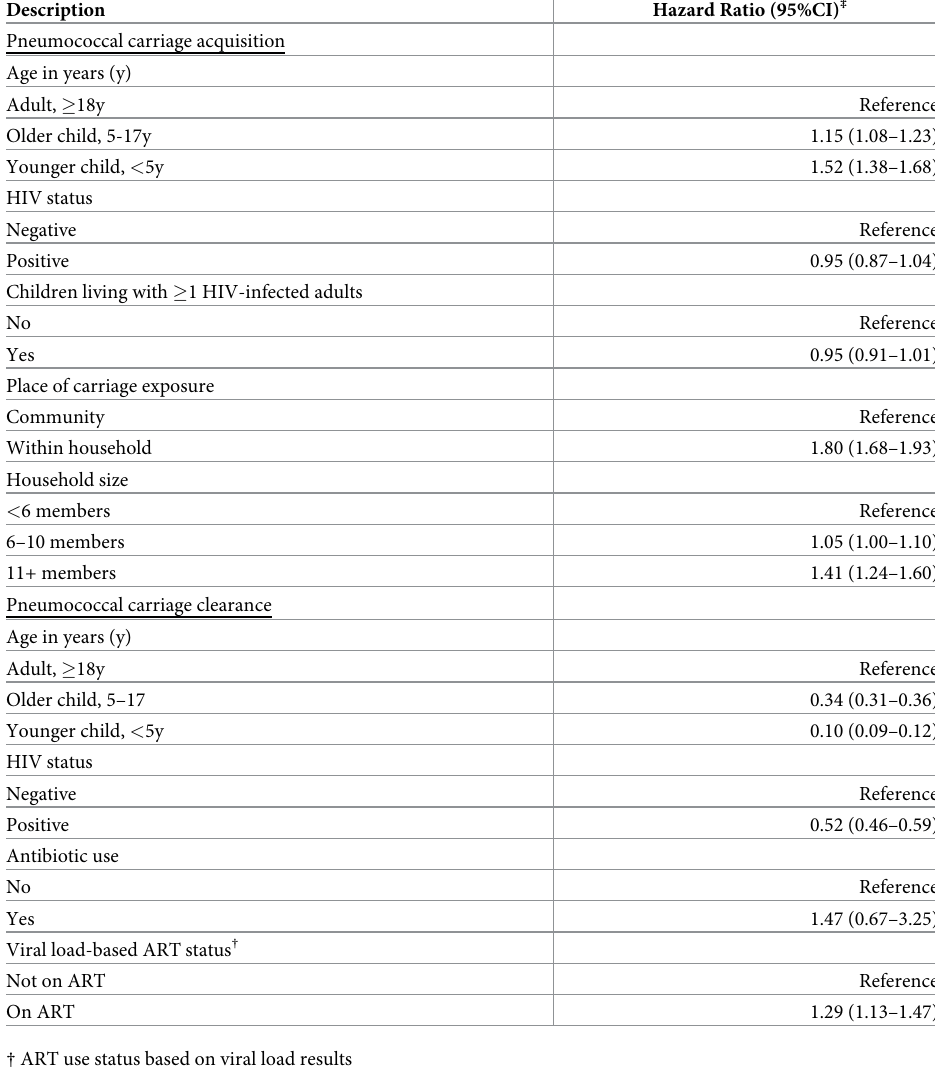
Table 2. Effects of included covariates on pneumococcal acquisition and clearance rates estimated in the hidden Markov